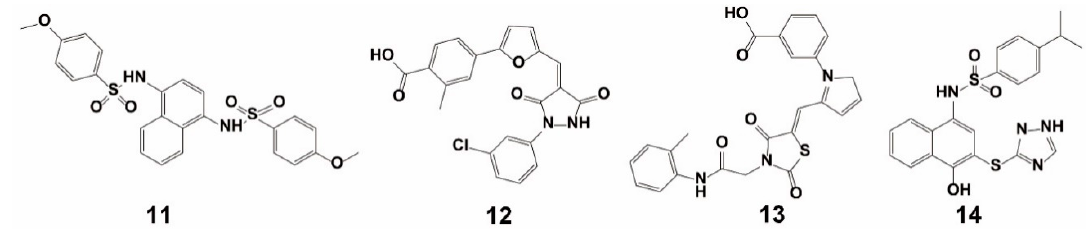
Figure 8. Structures of compounds 11–14.